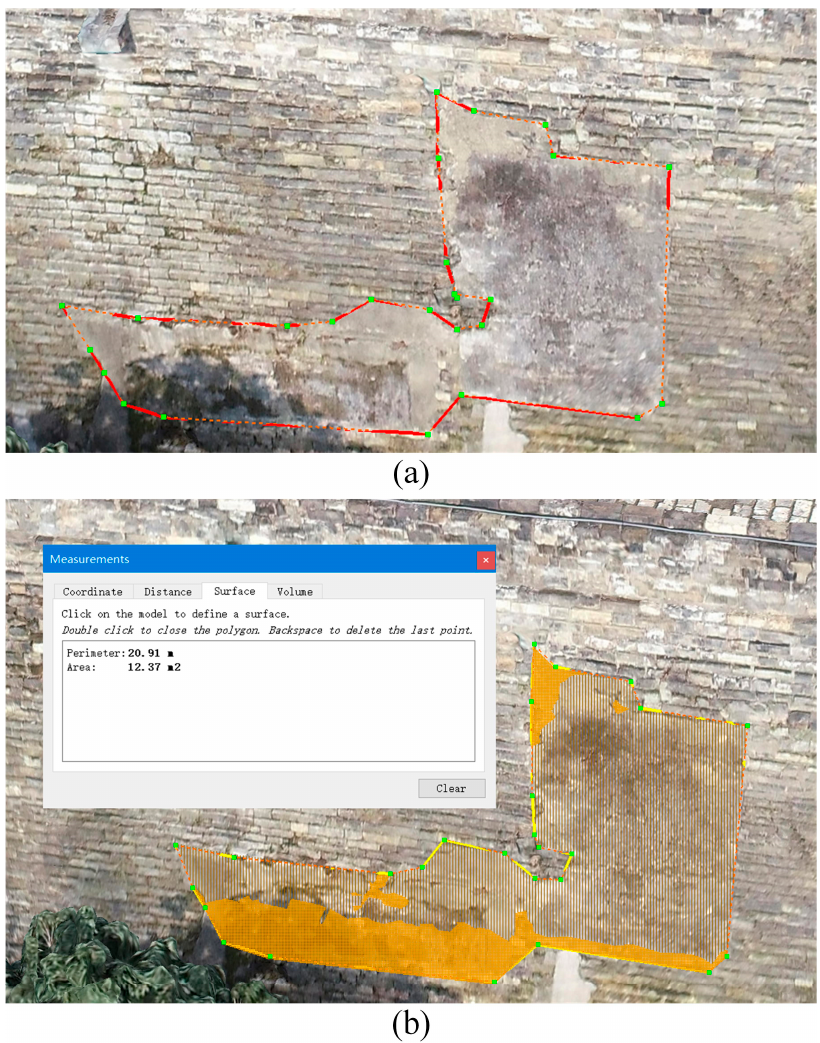
Figure 18. ( a ) The maximum shedding area of inner wall. ( b ) The perimeter and area of shedding